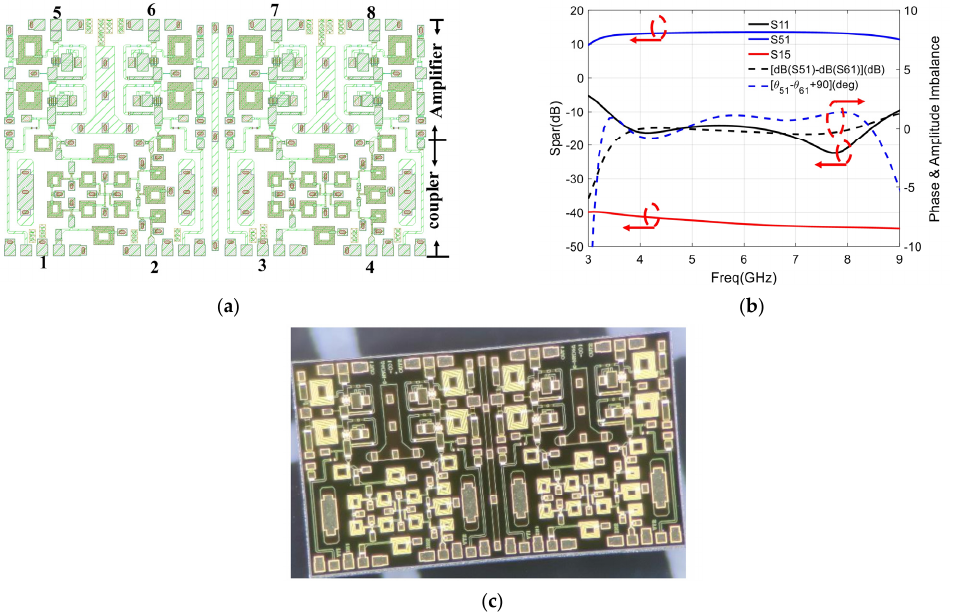
Figure 6. The layout design, simulation result, and the fabricated chip of the coupler and amplifier chip: ( a ) Layout design of the chip, ports 1 to 4 are input ports and ports 5 to 8 are output ports; ( b ) Simulation result of the chip; ( c ) The final fabricated chip.